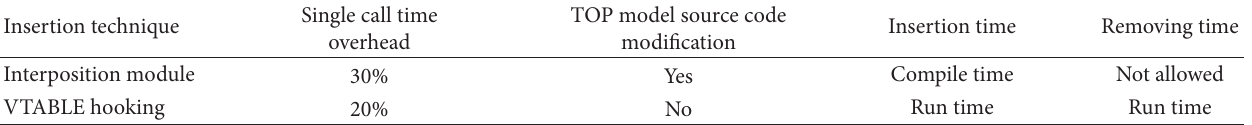
Table 3: Performance and usability